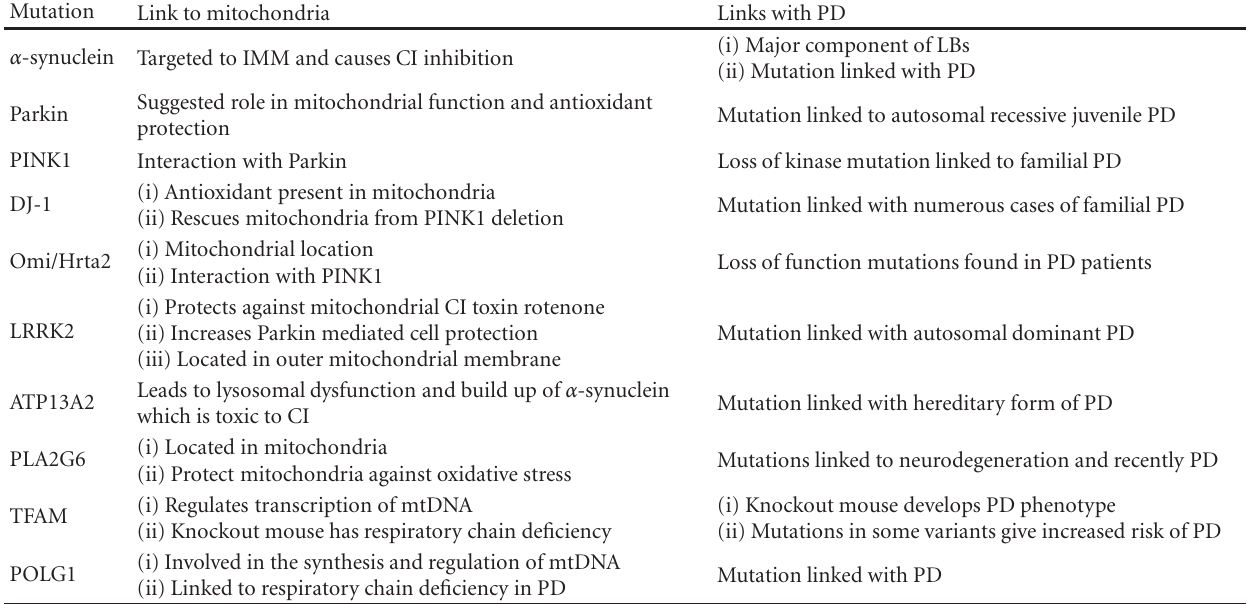
Table 1: Summary of mutations and links to mitochondrial dysfunction and